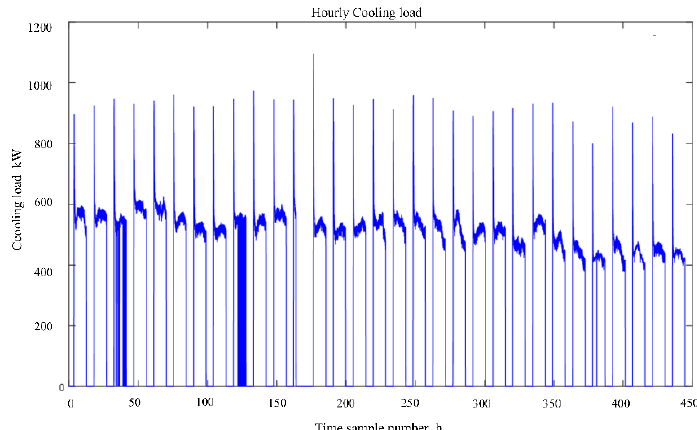
Figure 10. Hourly cooling load before pretreatment.